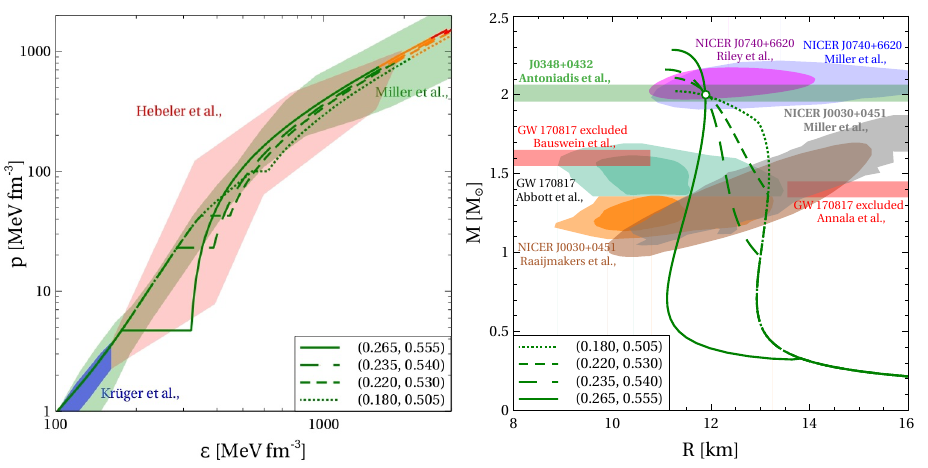
Figure 2. Hybrid EoS of cold electrically neutral β -equilibrated quark-hadron matter in the plane of energy density ε and pressure p (left panel) and the corresponding mass-radius relation of NSs (right panel). The shaded areas on the left and right panels represent the constraints on the NS EoS [2, 16, 17] and mass-radius relation [2, 3, 18–23]. The green, orange and red parts of the curves are in agreement, in tension and in contradiction with the pQCD constraint from Ref. [9], respectively. The empty circle on the right panel indicates the special point discussed in the